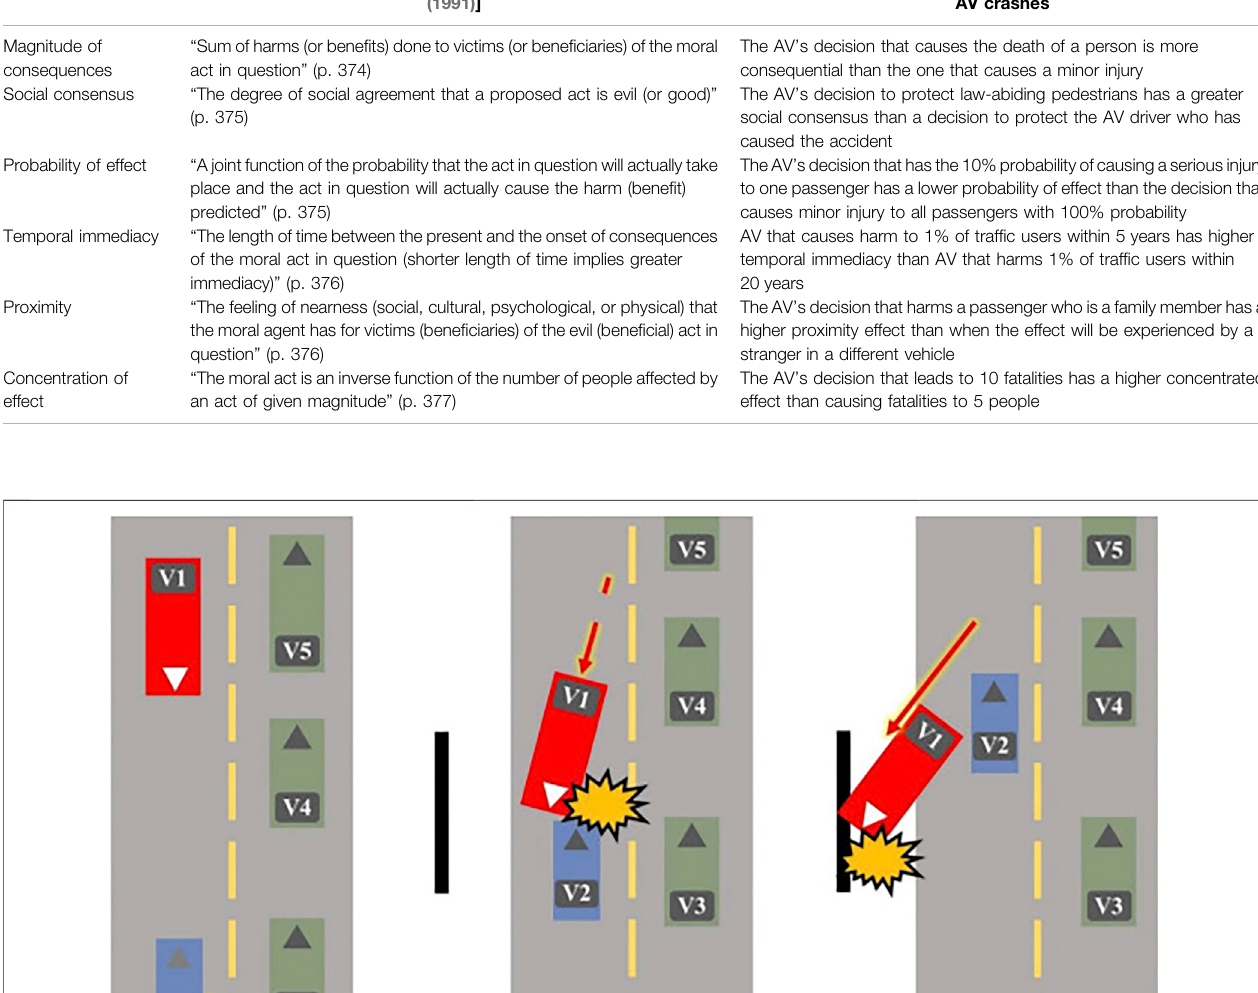
TABLE 2 | De fi nition of moral intensity factors. Factor De fi nition [source: Jones Magnitude of consequences